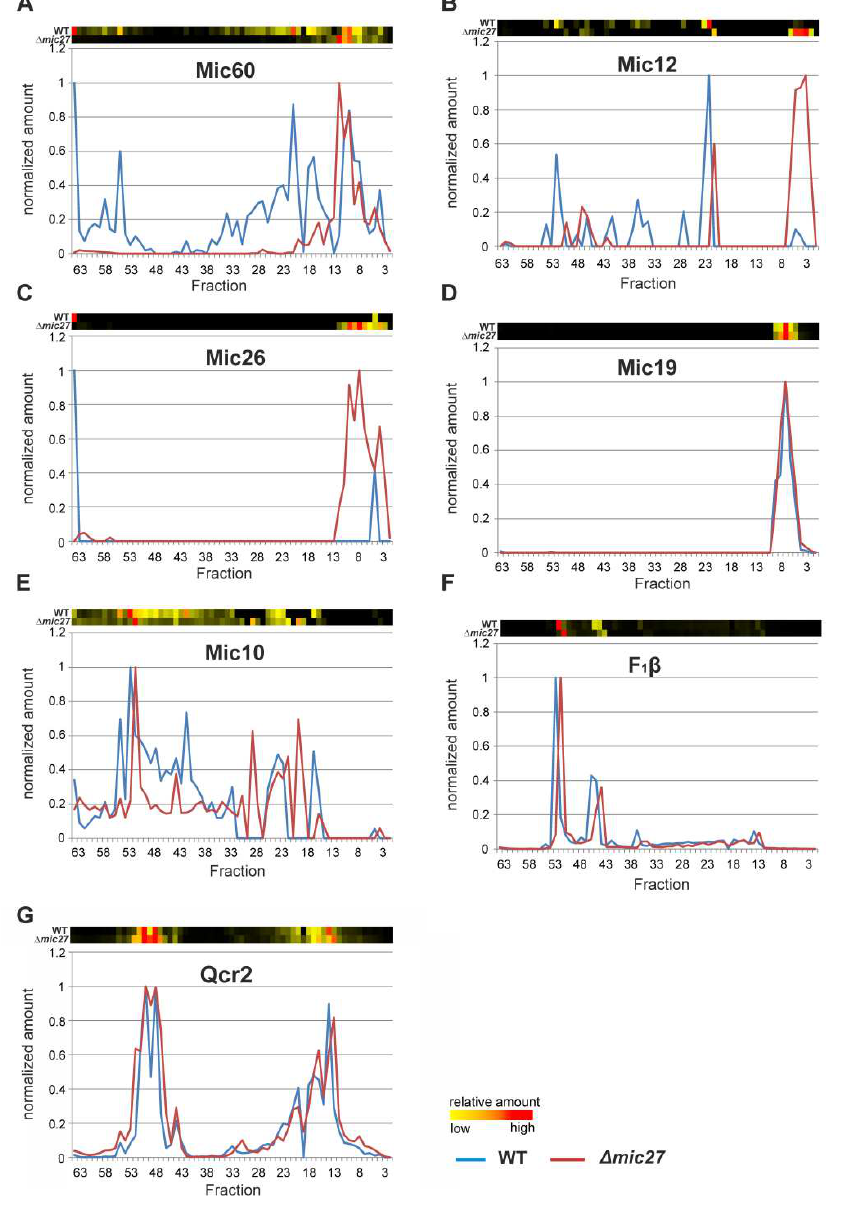
FIGURE 3: Deletion of Mic27 impairs stable assembly of the MICOS com- plex. (A-G) Complexome distribution profiles of Mic60 (A), Mic12 (B), Mic26 (C), Mic19 (D), Mic10 (E), F1β (F), and of Qcr2 (G) of wildtype (WT) and Δ mic27 -mitochondria (details see Fig- ure